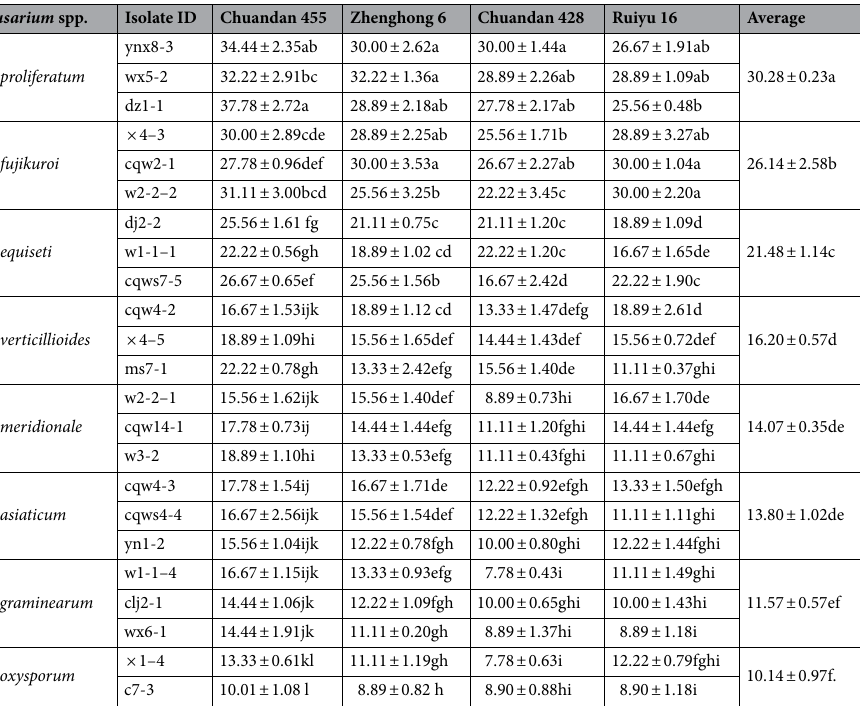
Table 3. The disease index values for maize sheaths inoculated with Fusarium spp. in different maize cultivars. Different lowercase in the same column shows a significant difference at the level of p = 0.05, according to Duncan’s least significant range